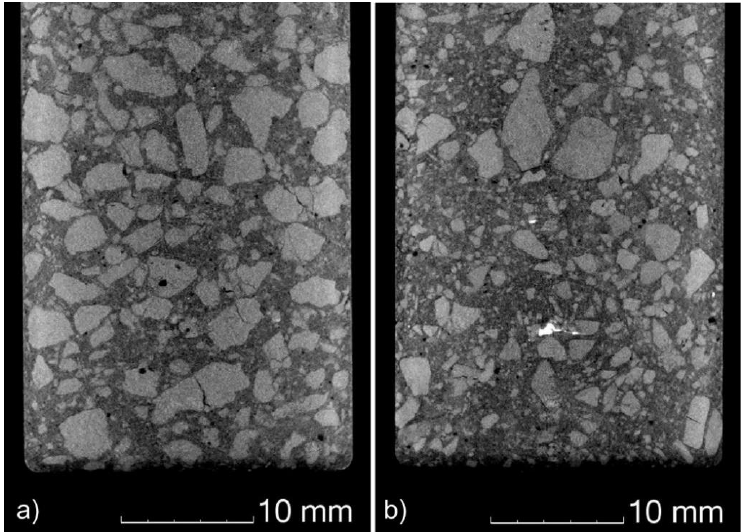
Figure 7. Computed tomography images showing cross-sectional areas of MgO-C bars of composition ( a ) R94A1:FM97 = 0:100 and ( b ) R94A1:FM97 = 100:0.